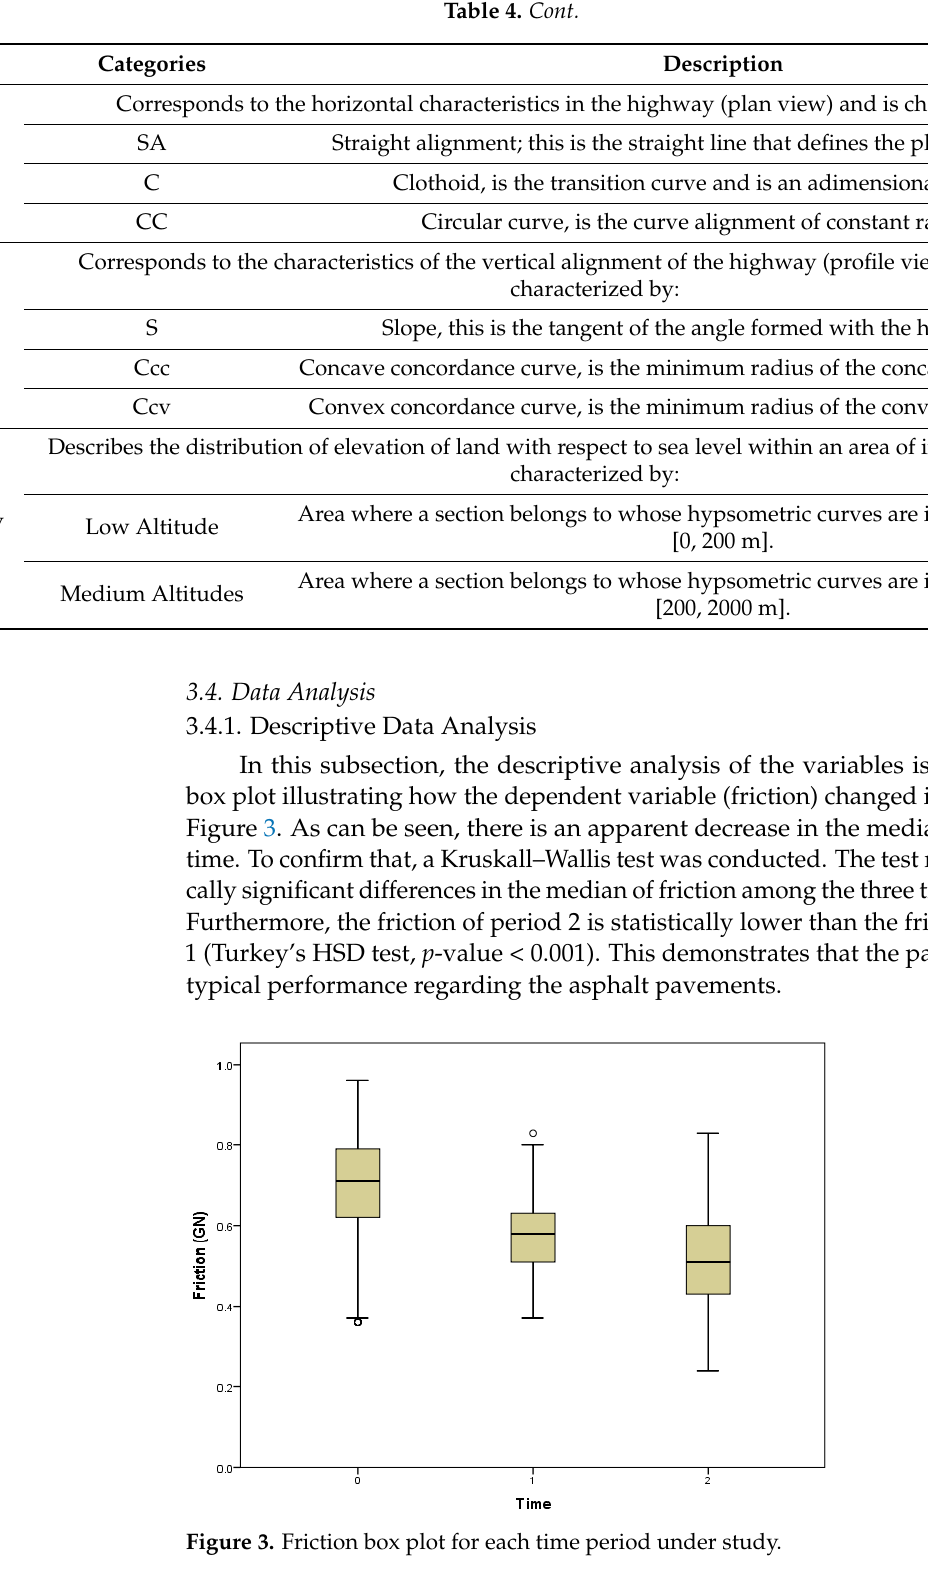
Figure 4. Observed friction values versus time for some pavement sections. A statistical summary of the quantitative variables is provided in Table 5. As can be seen, the average of the friction is 0.6 GN and ranges from 0.24 GN to a maximum of 0.96 GN. Regarding the traffic variables, the difference between the highest and lowest value of the annual average daily traffic (AADT) up to the observation year is 0.3274 × 10 6 vehi- cles, showing a large increase over time. Moreover, according to the Portuguese Road Pavement Design Manual [31], the minimum value for the accumulated annual average daily traffic of heavy vehicles (Ac.ADT heavy) fits within the traffic class T3 and T4 (300– 800 heavy vehicles), therefore in an intermediate traffic level at the beginning of the life of the pavements.